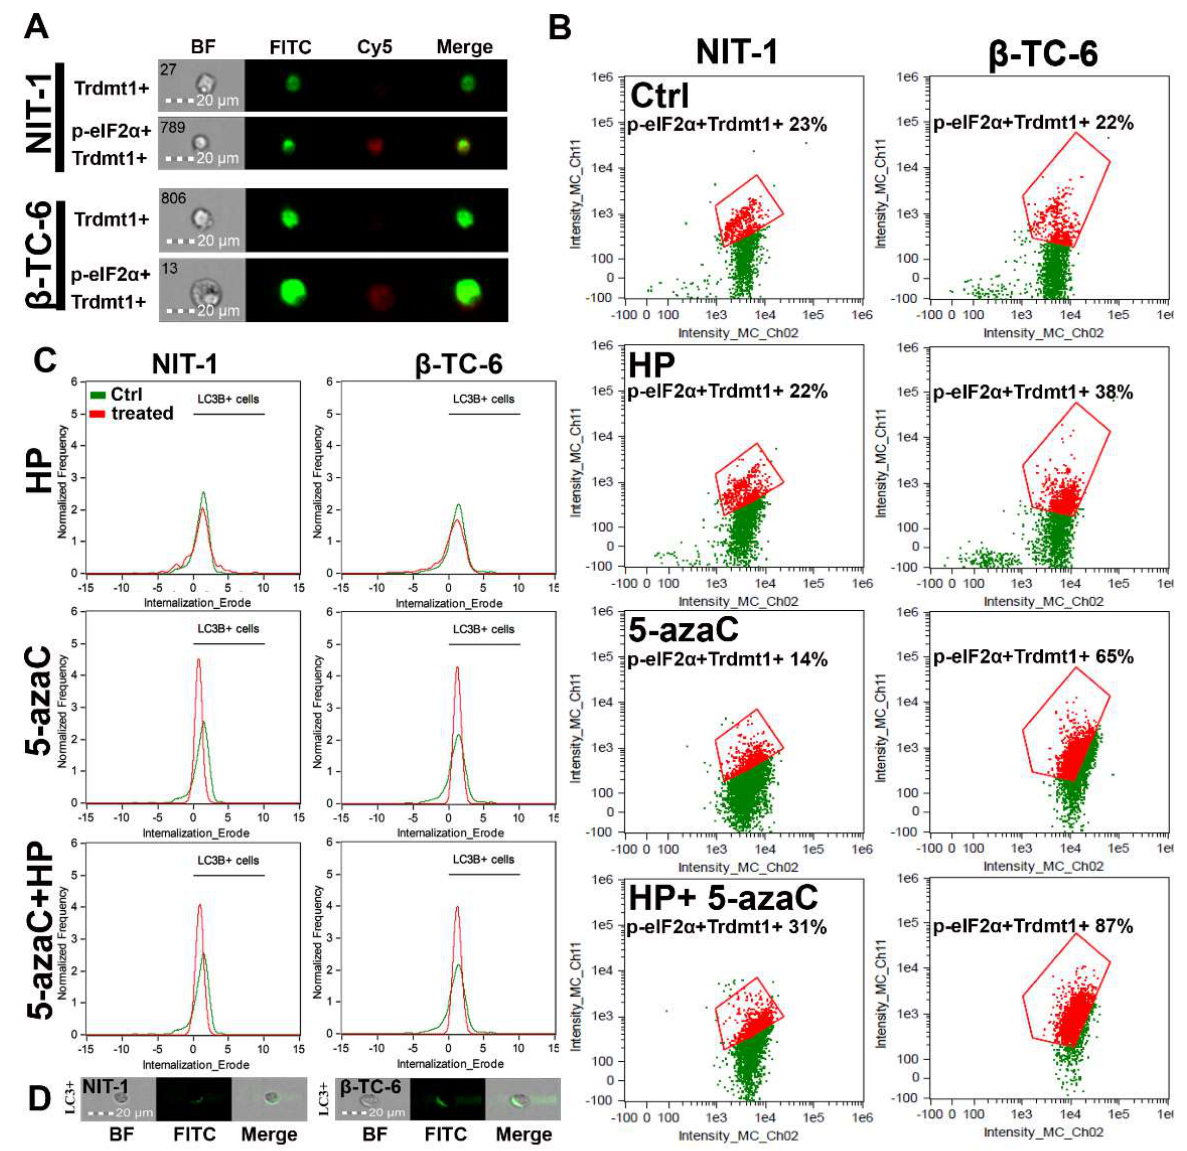
Figure 5. 5-AzaC post-treatment-mediated changes in Trdmt1 and p-eIF2 α signals ( A , B ) and au- tophagic marker LC3B ( C , D ) in hydrogen peroxide-treated mouse insulinoma NIT-1 and β -TC-6 cells. Insulinoma cells were stimulated with 100 µ M HP for 24 h and then post-treated with 1 µ M 5-azaC for 24 h. To analyze cellular subpopulation characterized by dual positive signals of Trdmt1 and p-eIF2 α , immunofluorescence and imaging flow cytometry were used. ( A ) Representative images are shown. BF, bright field; FITC, immunostaining of Trdmt1 using secondary antibody conjugated to Alexa Fluor Plus 488 (green); Cy5, immunostaining of p-eIF2 α using secondary antibody conjugated to Cyanine 5 (red); Merge, a merged image of FITC and Cy5. ( B ) Representative dot plots are also presented. Trdmt1-positive and p-eIF2 α -positive subpopulations are indicated in red and quantified [%]. ( C , D ) To analyze LC3B signals, immunofluorescence and imaging flow cytometry were used. ( C ) Representative histograms are shown (green, untreated samples; red, treated samples). Black horizontal lines are provided to emphasize LC3B-positive cell populations. ( D ) Representative images are also shown. BF, bright field; FITC, immunostaining of LC3B using secondary antibody conjugated to Alexa Fluor Plus 488 (green); Merge, a merged image of BF and FITC. Ctrl, control conditions; HP, hydrogen peroxide (H 2 O 2 ) treatment; 5-azaC, azacytidine treatment; HP+5-azaC, hydrogen peroxide treatment, and azacytidine